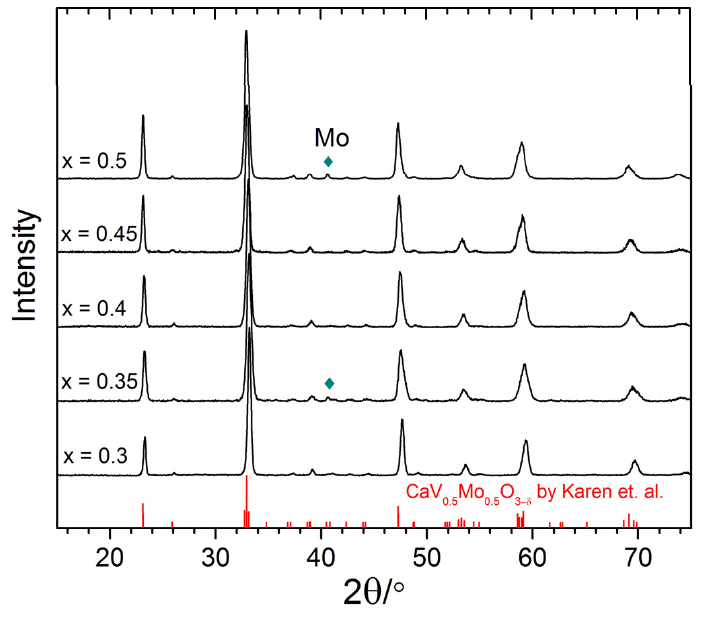
Figure 1. XRD patterns of as–prepared CaV 1–x Mo x O 3– δ (0.3 ≤ x ≤ 0.5) powders.